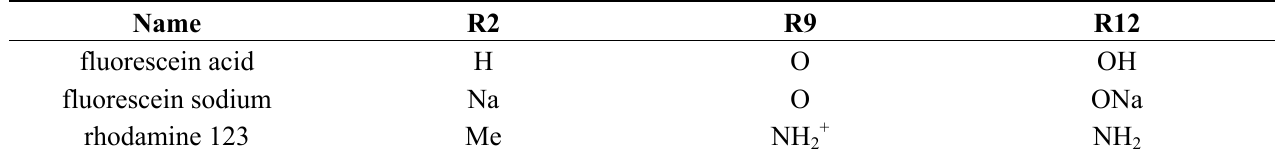
Table 2. Functional groups present in the common